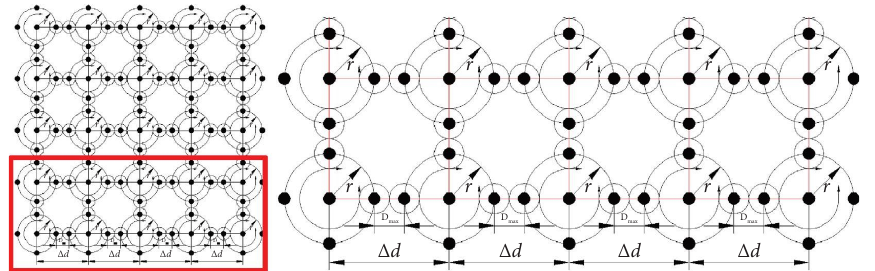
Figure 7: Schematic diagram of random movement of spatial